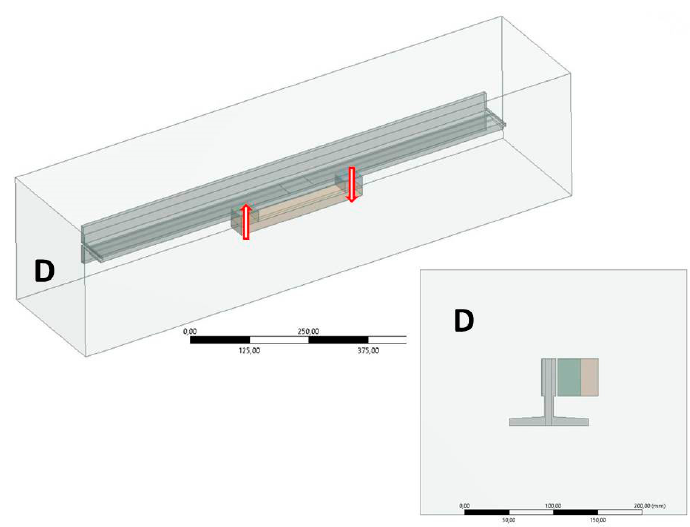
Figure 4. Model with air domain and polarization direction of permanent magnets.